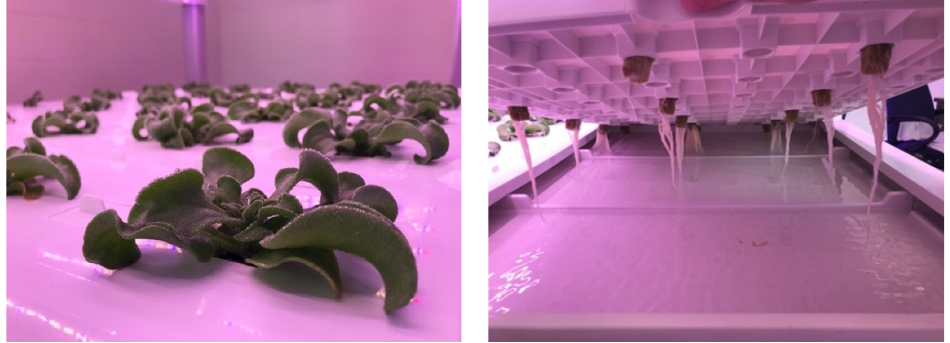
Figure 1. The Radix module (Sananbio U.S., Albuquerque, NM, USA), a vertical hydroponic system with a hybrid of nutrient film technique and deep water culture, demonstrating ice plant shoots ( left ) and roots ( right ) 10 days after transplanting.